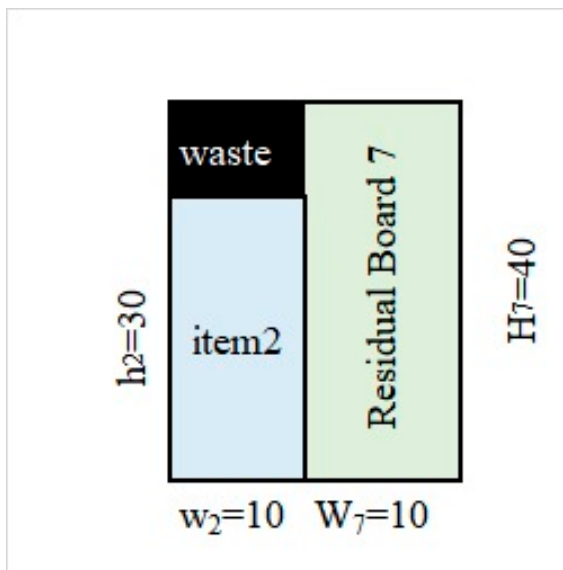
Figure 3. Using residual board 4 to cut item 2 of Example 1.